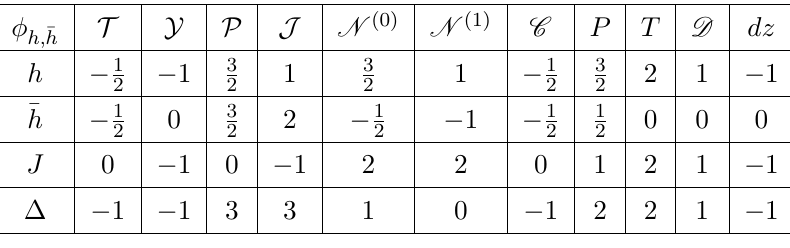
¯ h ) and spin/boost weights ( J, ∆)